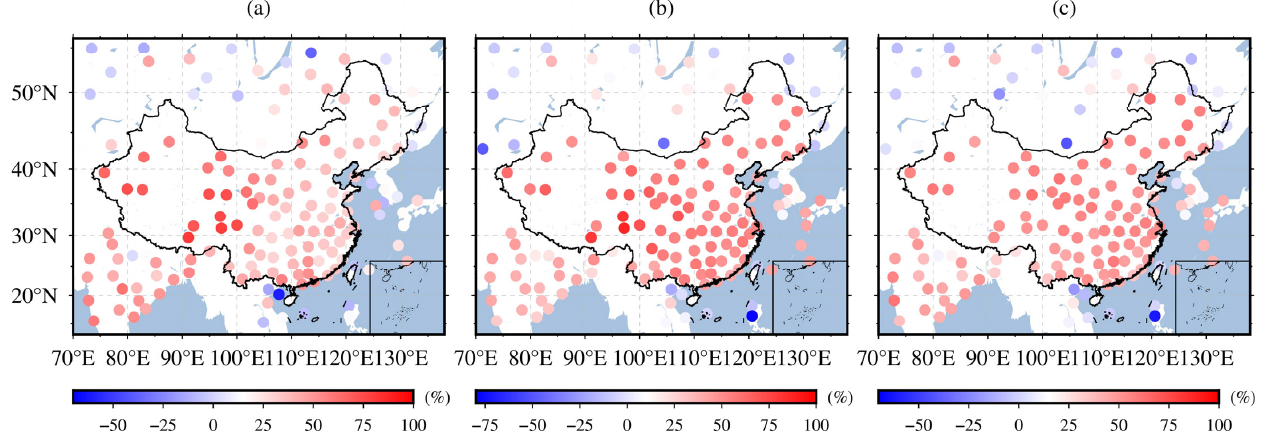
Figure 14. The RMSE reductions of the Hm2 model compared with different models for retrieving PWV: ( a ) Bevis model; ( b ) GPT3 model; ( c ) HGPT model.